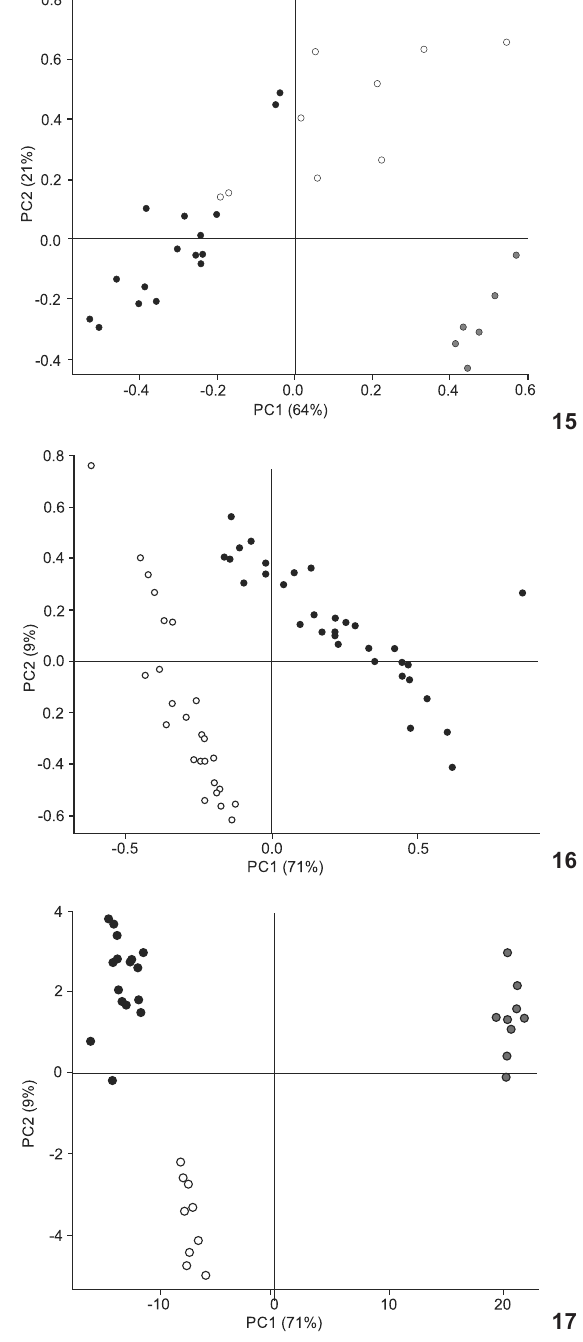
Figures 15-17. (15-16) Principal Components Analysis (PCA) for: (15) S. platyrhynus : females ( (cid:122) ), major males ( (cid:122) ), and minor males (light gray); (16) H. prasinata : females ( (cid:123) ) and males ( (cid:122) ); (17) Canonical Variate Analysis (CVA) of S. platyrhinus : females ( (cid:122) ), major males ( (cid:122) ), and minor males ( (cid:123) ).